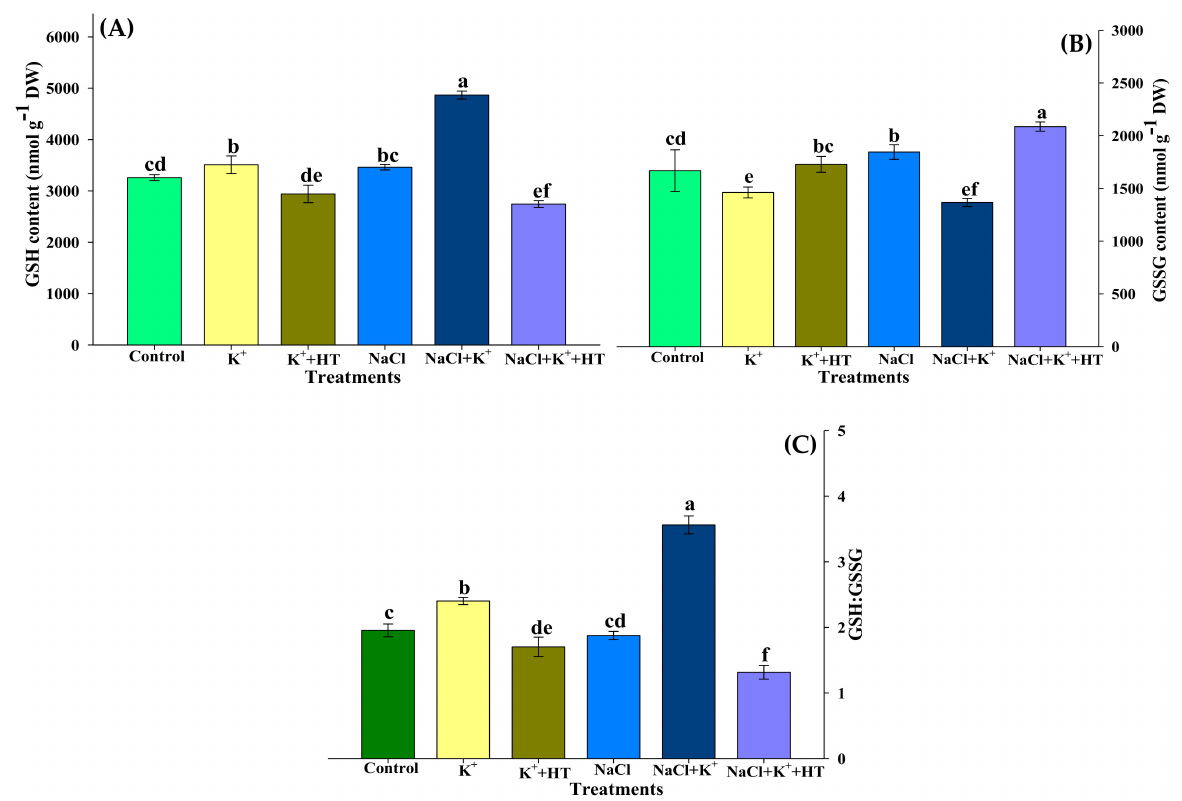
Figure 6. Effect of K + and NaCl on the non-enzymatic components of ascorbate–glutathione cycle in tomato seedling roots. ( A ) Reduced glutathione (GSH) content, ( B ) oxidized glutathione (GSSG) content, and ( C ) GSH:GSSG ratio. Double deionized water (control), 5 mM K 2 CO 3 (K + ), 100 mM NaCl (NaCl), 1 mM hypotaurine (HT: H 2 S scavenger). Values are means of five independent replicates, with bars indicating SE. Bars with different letters indicate that differences were statistically significant at p < 0.05 (DMRT).